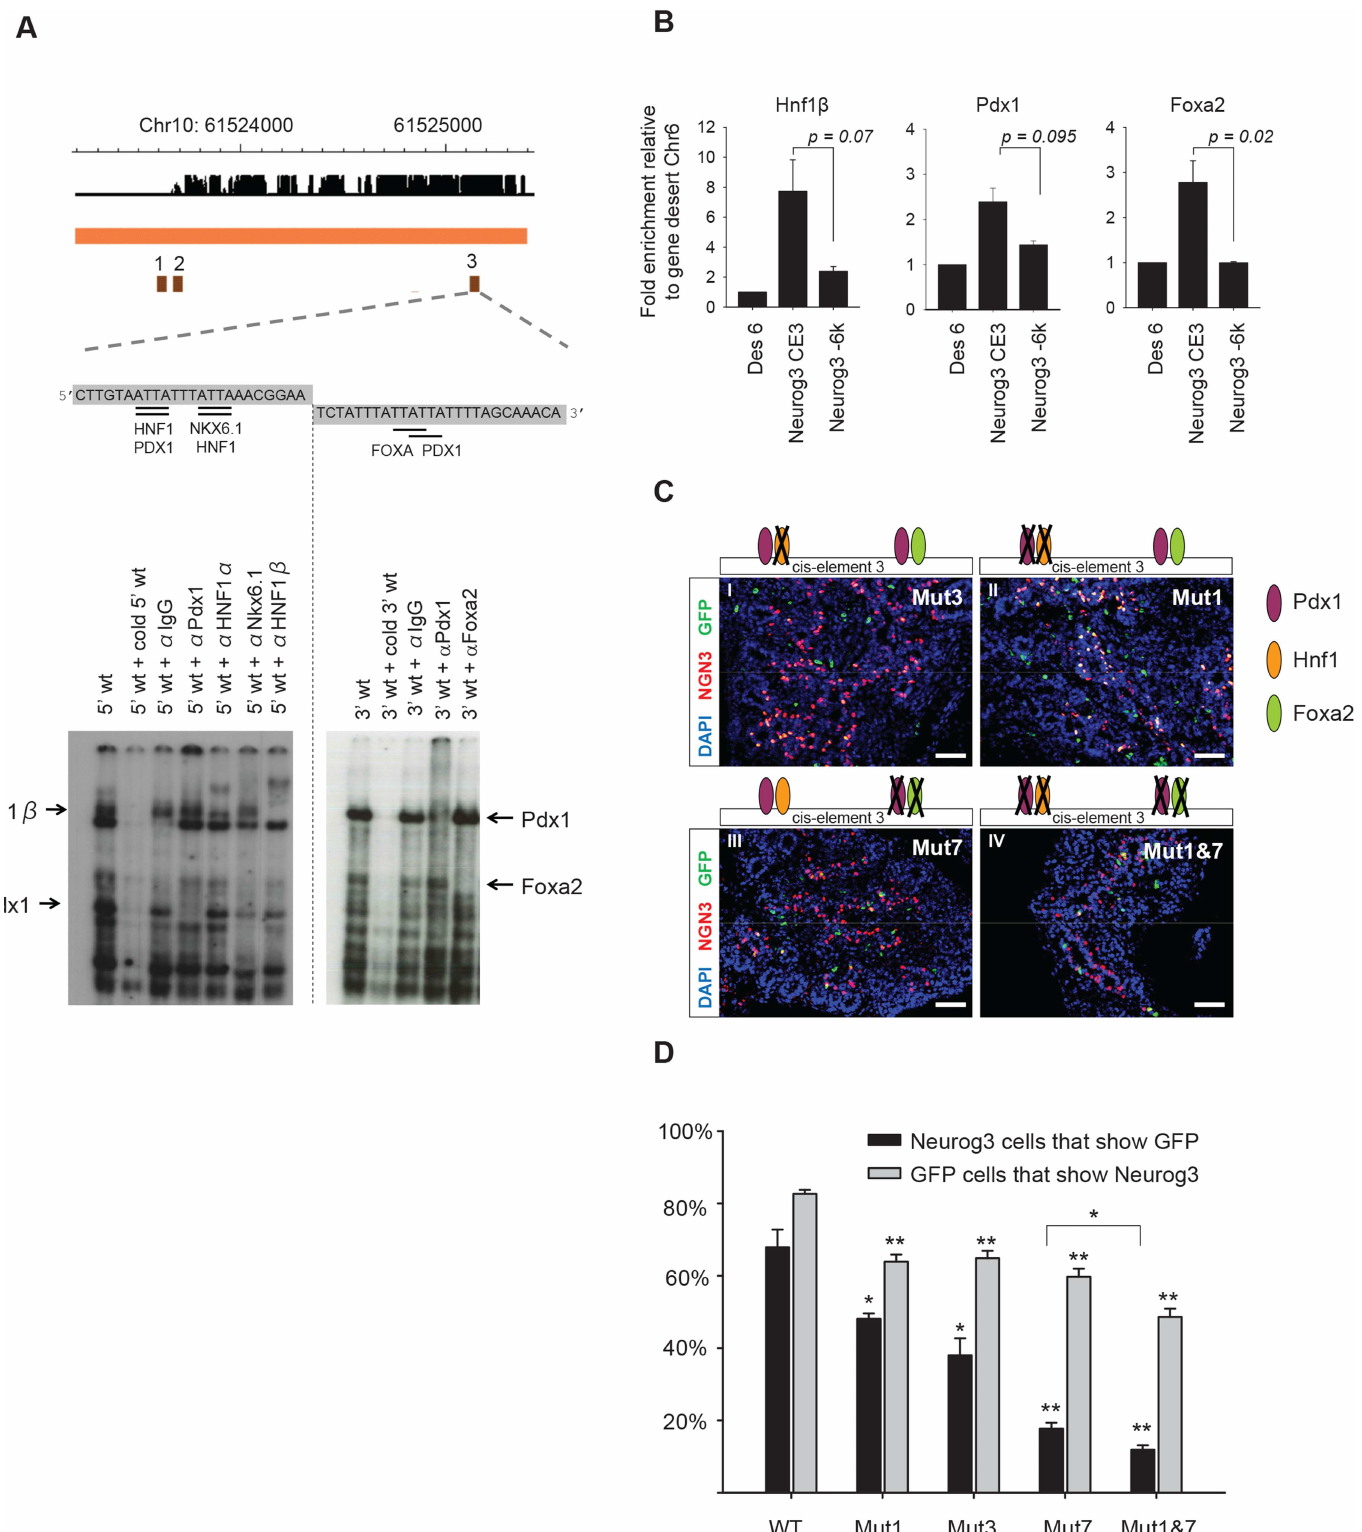
Fig 3. Identification of cis-regulatory mutations that disrupt activation of Neurog3 in pancreatic progenitors. A. Bindingof Hnf1b, Pdx1 and Foxa2 to cis-element 3 of the Neurog3enhancer using EMSAs with nuclearextracts from E13.5 pancreatic buds. The 5’ part of the cis-element 3 sequencebinds